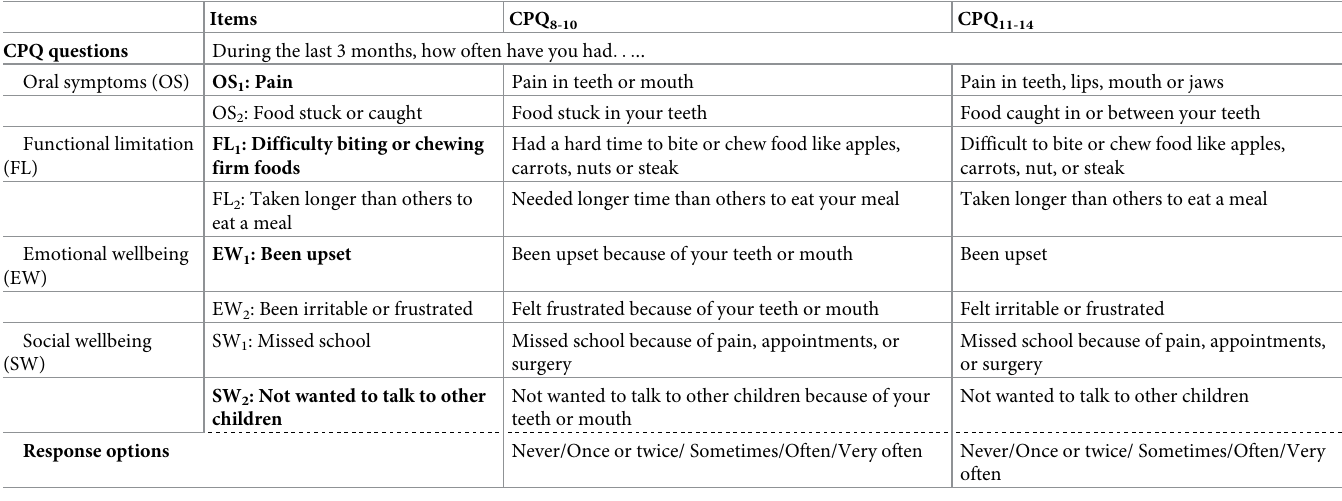
Table 1. The 8-item child perception questionnaire (CPQ 8-10 and CPQ 11-14 ). Items CPQ 8-10 CPQ 11-14 CPQ